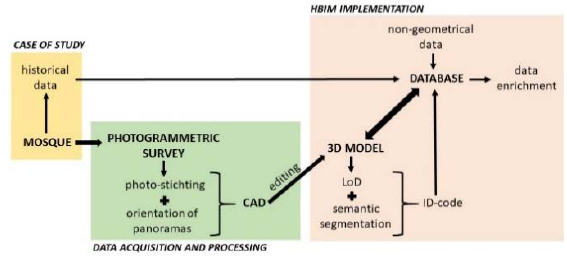
Figure 1. The methodology